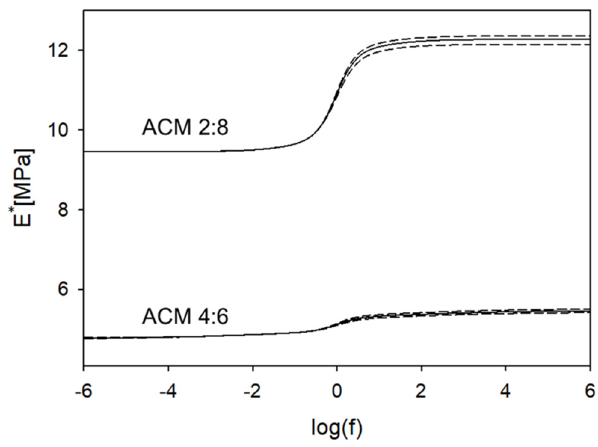
Figure 6. Master curves of the complex viscoelastic modulus for ACM 2:8 and ACM 4:6; solid lines: median value, dotted lines: 50% quantile.